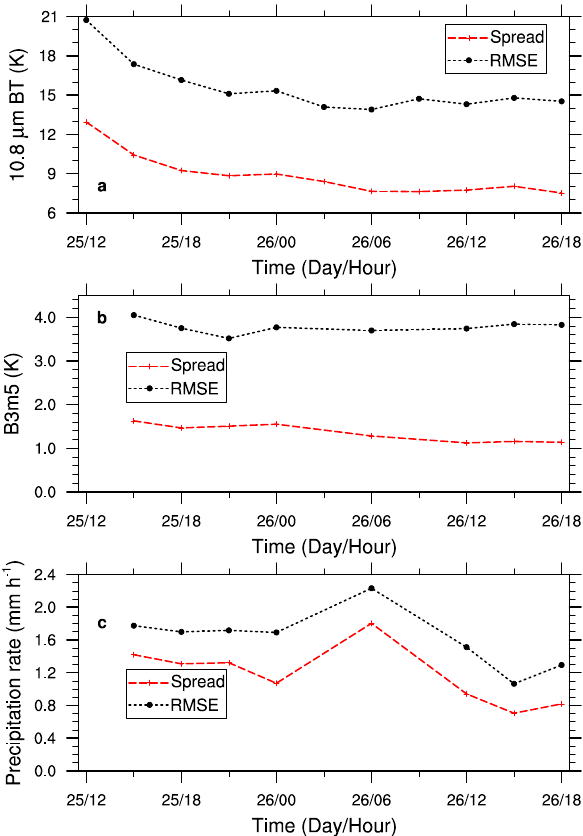
Fig. 5. Time series of SEDS for (a) 10.8µm BT less than 250K, Fig.5. Timeseriesof SEDSfor(a)10.8 µ m BTlessthan 250 K,B3m5 largerthan − 8Kand(c)instantaneous B3m5 larger than − 8K and (c) instantaneous precipitation greater precipitation greater than 1 mm h − 1 . SEDSscores were calculated over the domain shown in Fig. 3. than 1mmh − 1 . SEDS scores were calculated over the domain shown in Fig. 3.